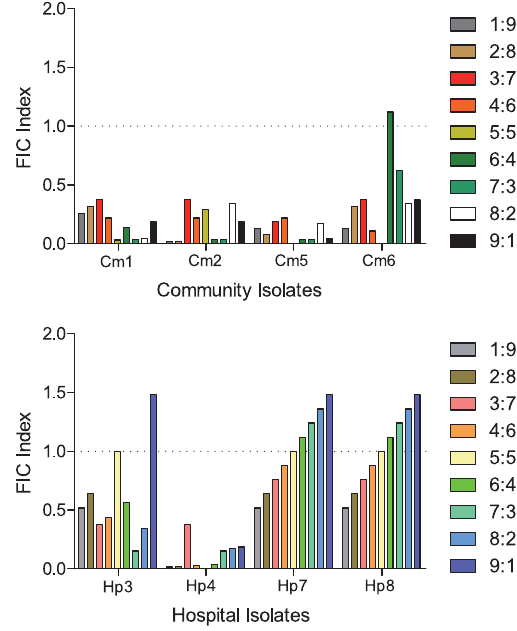
FIGURE 3. Susceptibility of ESBL Isolates to Gentamicin- Ceftriaxone antibiotics cocktail Varying proportions of Gentamicin and Ceftriaxone antibiotics ranging from 1:9 to 9:1 were mixed according to the continu- ous variation checkerboard method and seeded into Mueller Hinton agar. The ESBL producing organism was streaked on the surface of the agar plate. The set up was done in triplicate with a control containing no antibiotics and these were incu- bated at 37 o C for 24 hours and observed for growth. The MICs of the various combinations were determined and interactions between the antimicrobial agents were assessed by determin- ing their Fractional Inhibitory Concentration [FIC] index ratios where FIC index value below unity signi fi es synergism, ≥ 1 ; indifference, and ≥ 2; antagonism (Cm1, Cm2, Cm5, and Cm6 represent community isolates, while Hp3, Hp4, Hp7, and Hp8 represent hospital isolates respectively).